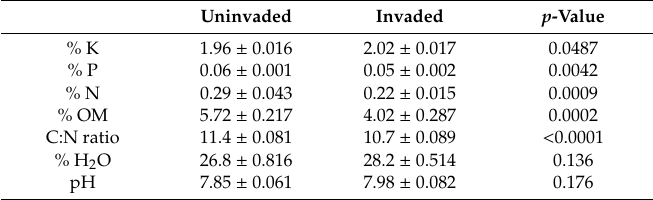
Table 1. Total soil nutrient and moisture contents (mean ± standard error, n = 25 per